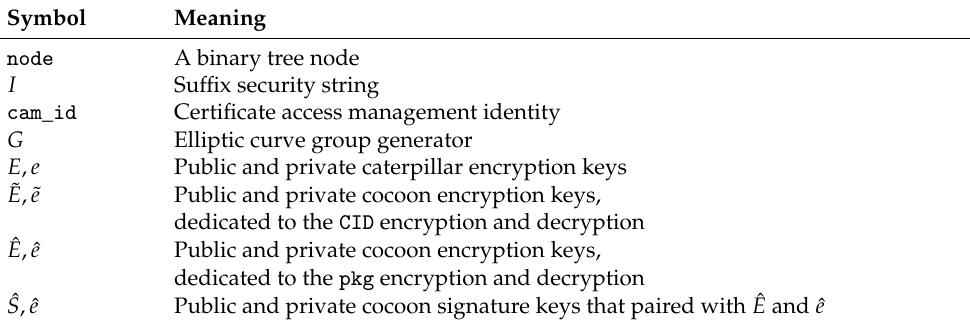
Table 1. General notation and